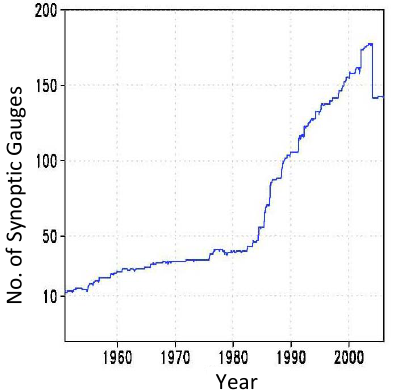
Fig. 4. Spatial distribution of annual average of number of Fig. 4 . Spatial distribution of annual average of number of synoptic gauges for 0.25°×0.25° grid cells over Iran (1998-2006).